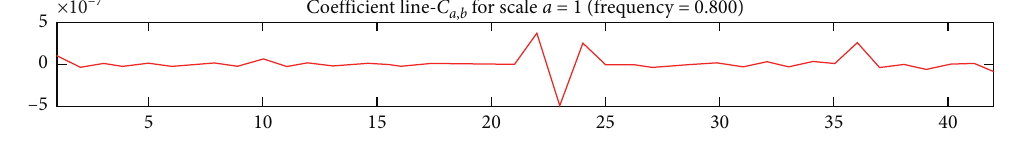
Figure 26: Wavelet coefficients without